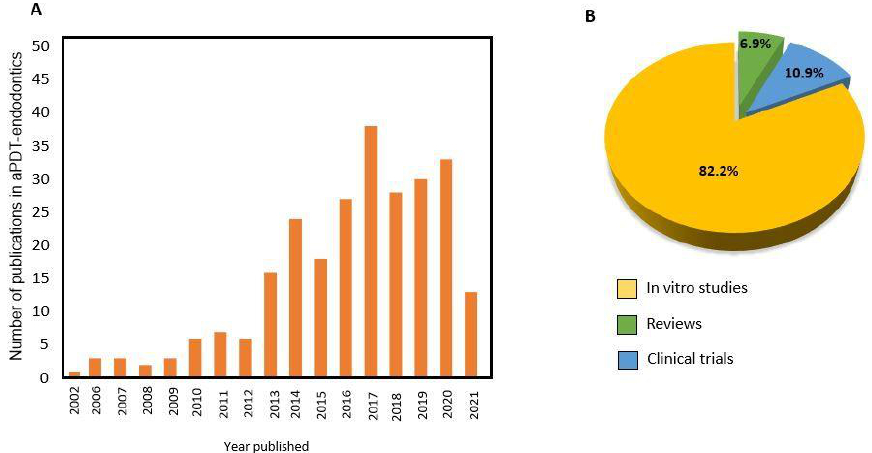
Figure 3. ( A ) Over time, the number of publications containing the term “antimicrobial photodynamic therapy AND endodontics” via the searched database and ( B ) hese data represent a synopsis of aPDT investigations in the endodontic literature and reviews in the subject.